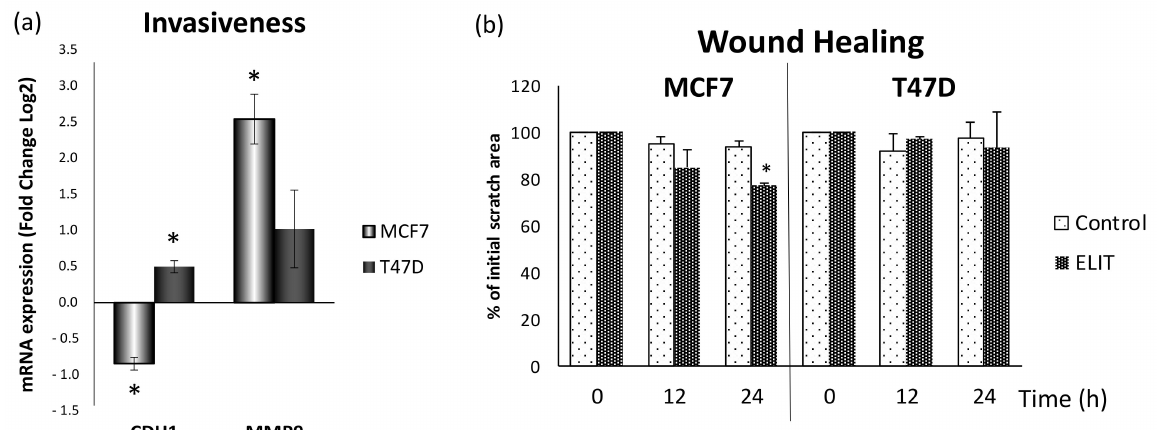
Figure 7. Invasiveness and cell motility were increased after ELIT treatment in the MCF7 cell line. ( a ) CDH1: cadherin-E; MMP9: Matrix Metalloproteinase 9. Breast cancer cells were incubated for 24 h with vehicle (DMSO) or ELIT. Data are represented as fold change (log2) of mRNA expression with respect to vehicle-treated cells, set at 0, of each cell line. Data represent means ± SEM ( n = 6). ( b ) Area of the wound that remained open after 24 h with ELIT treatment. Data are represented as a percentage of the initial scratch area with respect to vehicle-treated cells of each well, set at 100, of each cell line. Data represent means ± SEM ( n = 3). * Statistically significant difference between treated and vehicle-treated cells (Student’s t -test, p < 0.05).